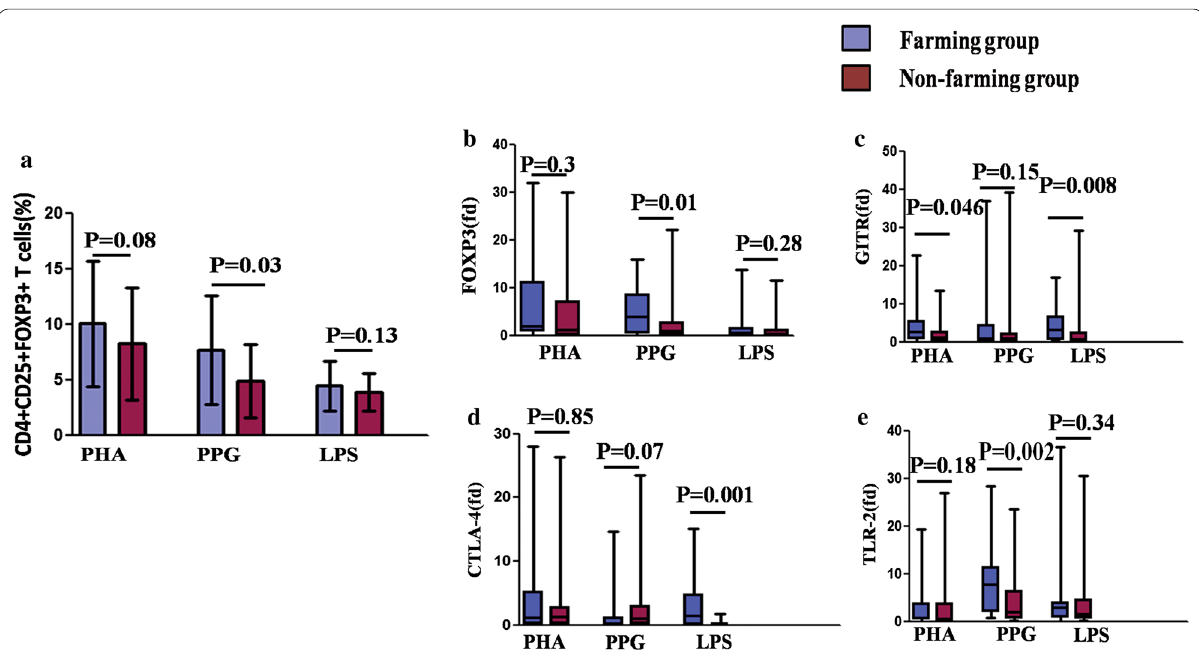
Fig. 3 Quantity and specific gene expression of Tregs showed up-regulation in the farming group after LPS and PPG stimulation. a CD4 CD25 FOXP3 T cell percentage in CBMCs (relative to unstimulation). The values are represented as mean + + + compare the two groups. b FOXP3 gene expression in neonatal CBMCs. c GITR gene expression in neonatal CBMCs. d CTLA4 gene expression in neonatal CBMCs. e TLR2 gene expression in neonatal CBMCs. We used fold difference (fd) The gating strategy used is illustrated in Additional file 1: S1. The values are represented as median (25%/75% IQR), and Mann–Whitney Rank Sum Test was used to compare the two groups. Statistical significance is indicated by P values <